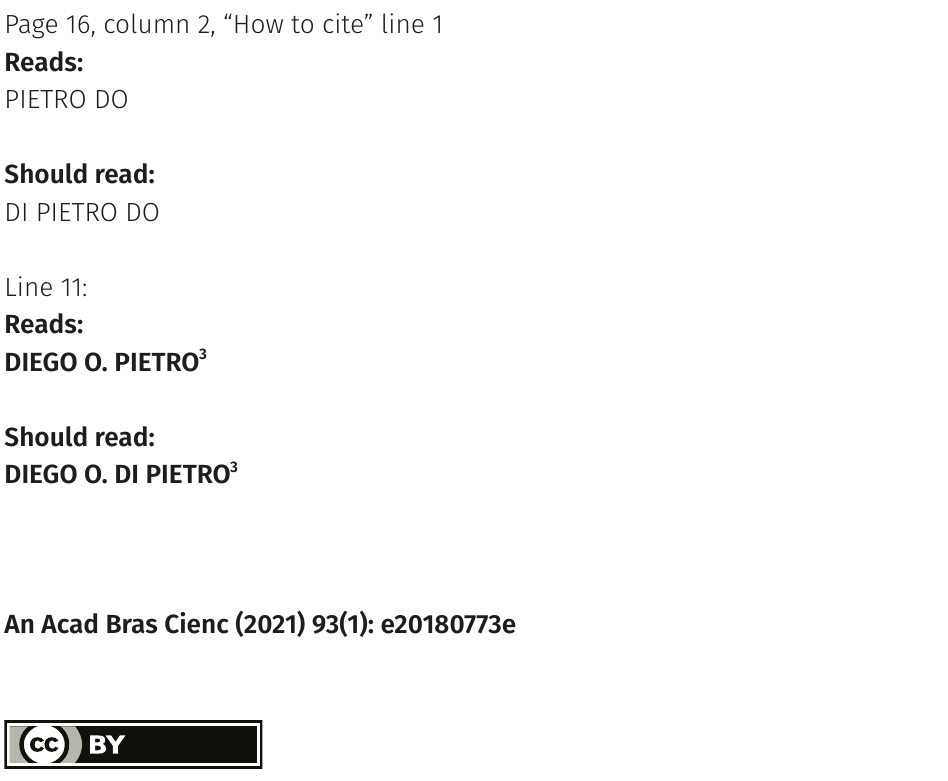
Figure 4. Power spectrum of the first third (left) and the final third (right) of an advertisement call of P. aff. albonotatus (above) and P. santafecinus